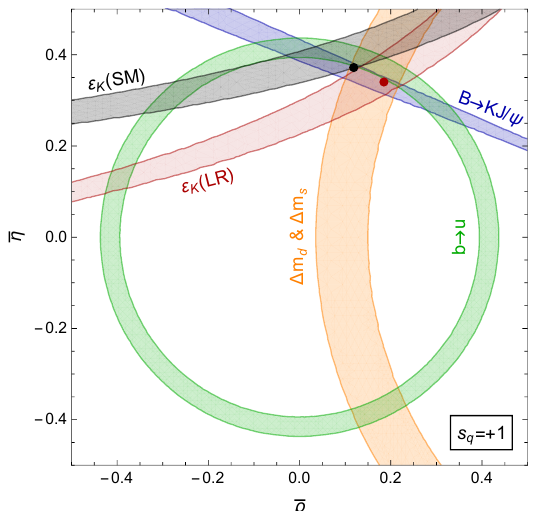
Figure 4 . 68% C.L. contours from various flavor observables in the ¯ ρ − ¯ η plane for two scenarios, namely the SM, M , and the case with the best fit values for the LR parameters, H,W R → ∞ { M H , M W , t 2 β s α , α } ’ { 200 TeV , 21 TeV , − 0 . 01 , 3 . 04 } . The difference is only noticeable in the case R of ε for which the SM and LRM bands are shown in black and red, respectively. Each band was K obtained including s → u and b → c observables in order to marginalize with respect to A and λ . The best fit points in the SM and LRM are shown as black and red points,